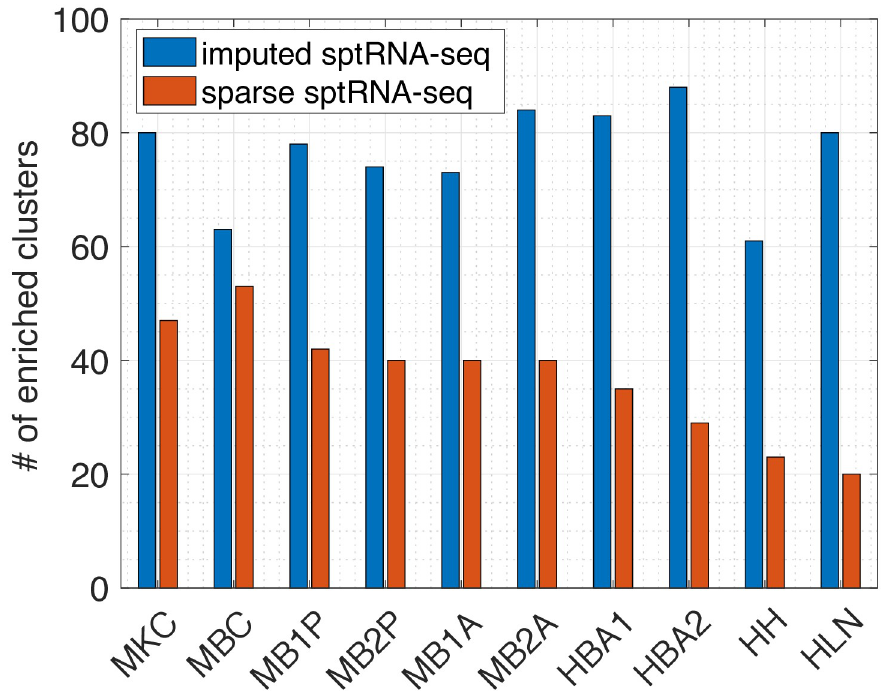
Fig 6. Enrichment analysis on the sparse and imputed sptRNA-seq data. The total number of significantly enriched clusters (with at least one enriched GO term with FDR adjusted p-value < 0.05) in the 10 tissue sections are shown.